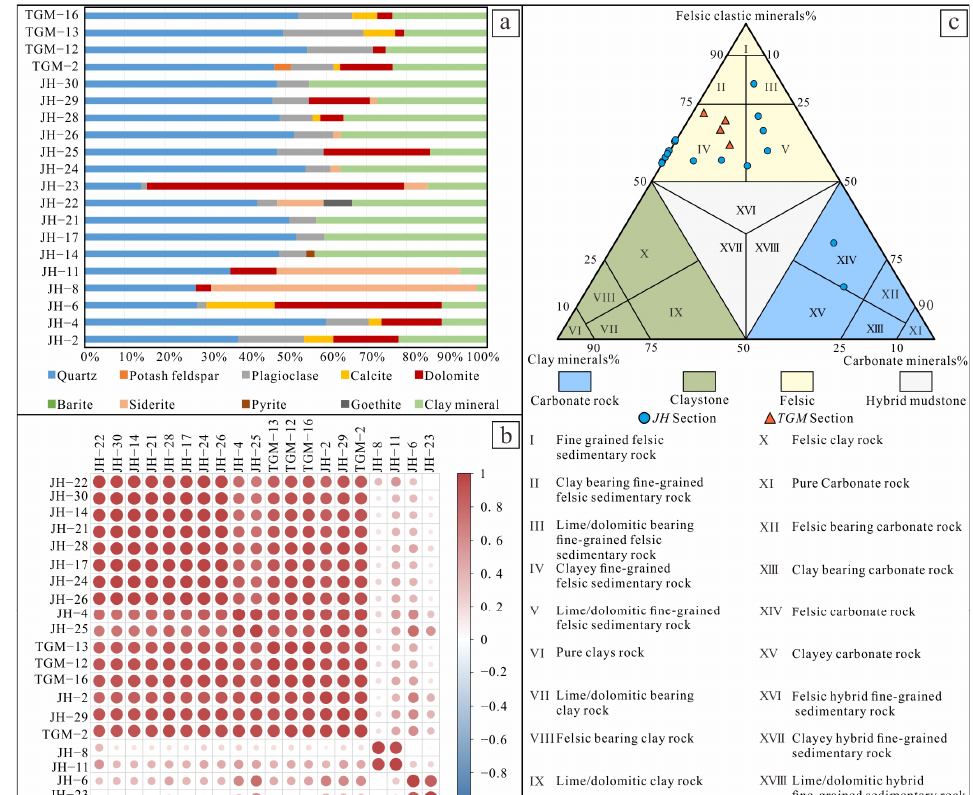
Figure 4. Mineralogical characteristics of fine-grained sedimentary rocks. ( a ) Mineralogical composition of fine-grained sedimentary rocks; ( b ) Correlation heat map of fine-grained sedimentary rocks; ( c ) Classification of mineral petrology.